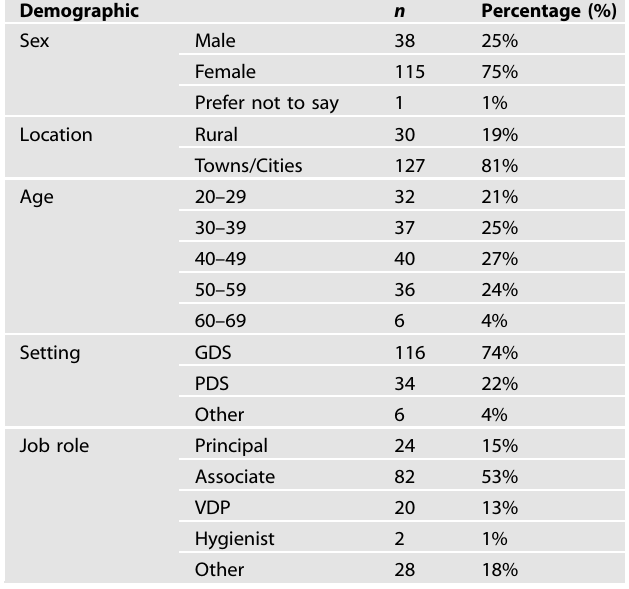
Table 1. Respondent